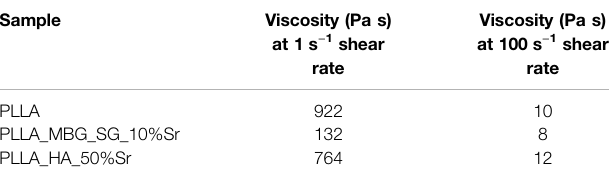
TABLE 2 | Values of viscosity at a shear rate of 1 and 100 s − 1 for PLLA and composite samples Sample